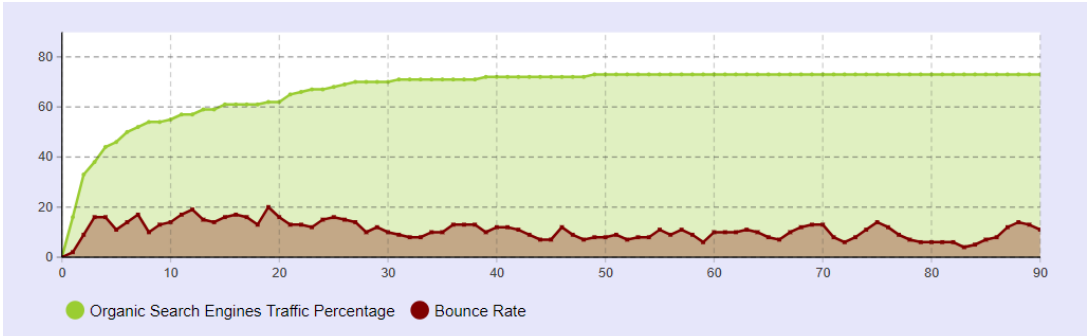
Figure 9. Optimization of the organic search engine traffic percentage in a time range of 90 sequential days. The horizontal axis demonstrates the specific time range from 0 up to 90 days of the simulation run. The vertical axis depicts the percentage of organic search engine traffic.